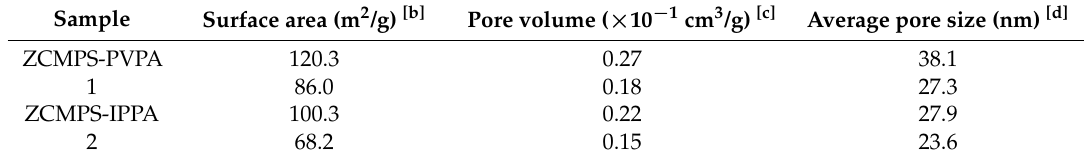
Table 1. The BET surface areas, pore volumes, and average pore sizes of ZCMPS-PVPA, ZCMPS-IPPA, and 1 [a] .